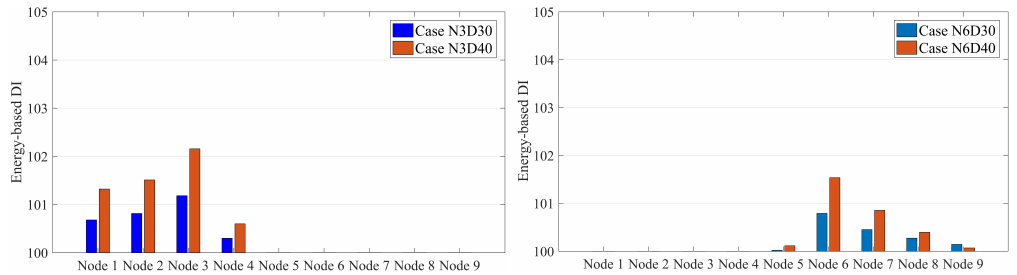
Figure 9. Energy-based DIs along a simply supported beam subjected to moving sprung mass with a speed of 2.5 m/s for ( a ) Cases N3D30 and N3D40 and ( b ) Cases N6D30 and N6D40.